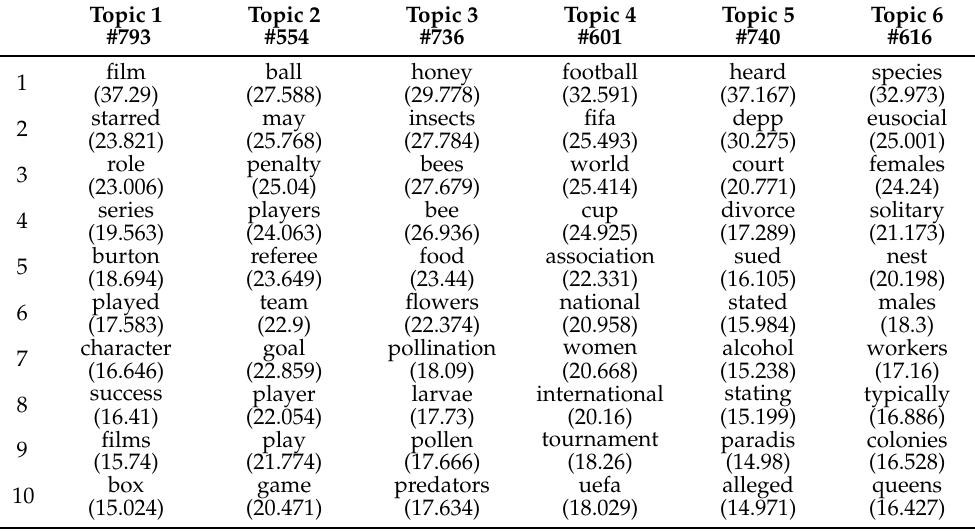
Table A14. Each column lists the top 10 representative words per dimension of the basis matrix H